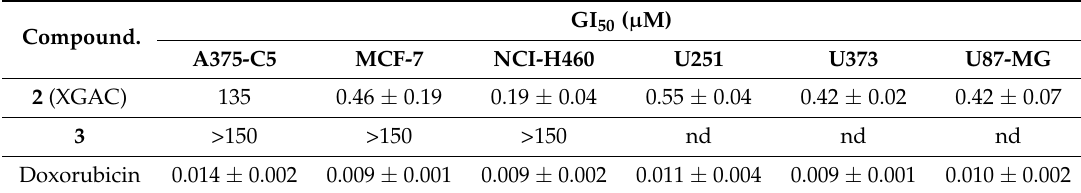
Table 1. Cell growth inhibitory activity of synthetic xanthones 2 and 3 .